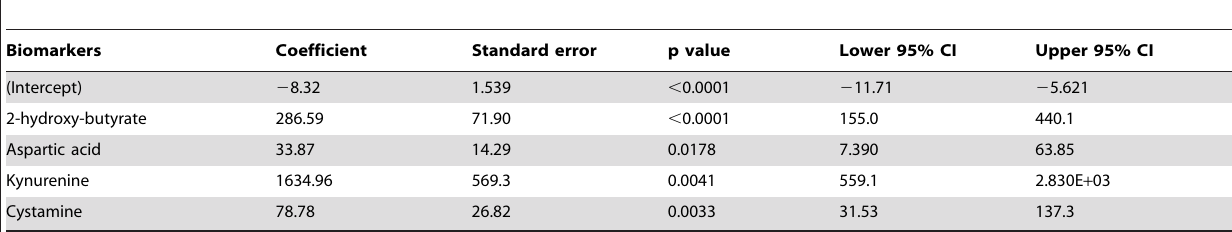
Table 4. Biomarkers for detecting colorectal cancer selected by the multiple logistic regression